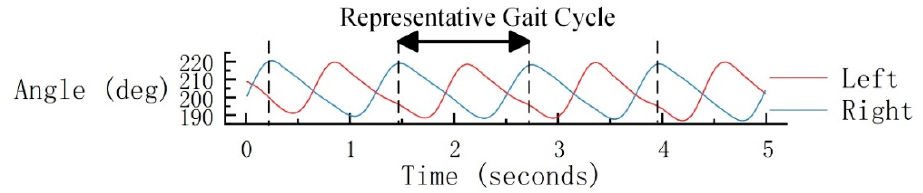
RGC is defined as the time when the right heel touches the ground [25]. The angle repre- sents the angle between the subject’s thigh and the back of the body. Figure 5. Hip gait data and filtered data. Figure 5. Hip gait data and filtered data.